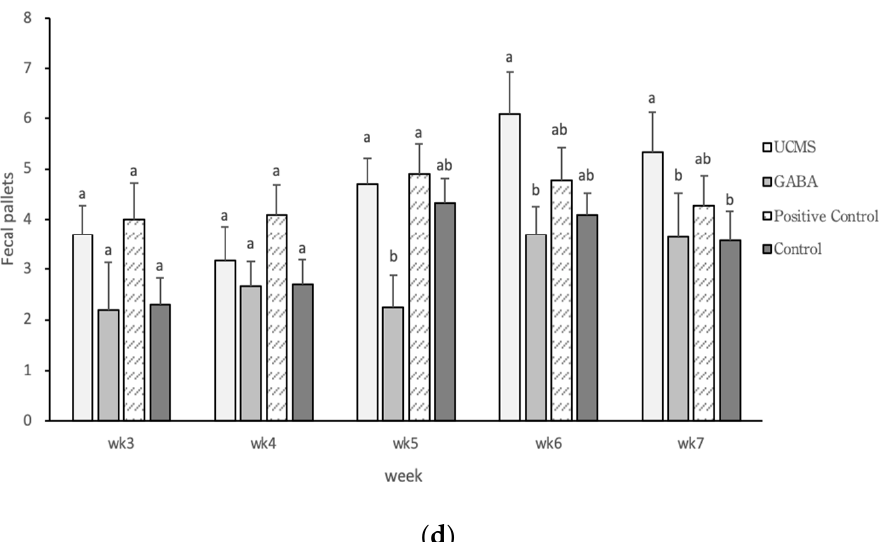
Figure 4. Effect of GABA feed by vegetable soybean on the total distance of mice in open field test (OFT). Data are represented as mean ± SD. ( a ) total travel distance ( b ) number of rearings ( c ) number of grooming episodes ( d ) number of defecations. Group with different letter superscripts are significantly different ( p < 0.05).